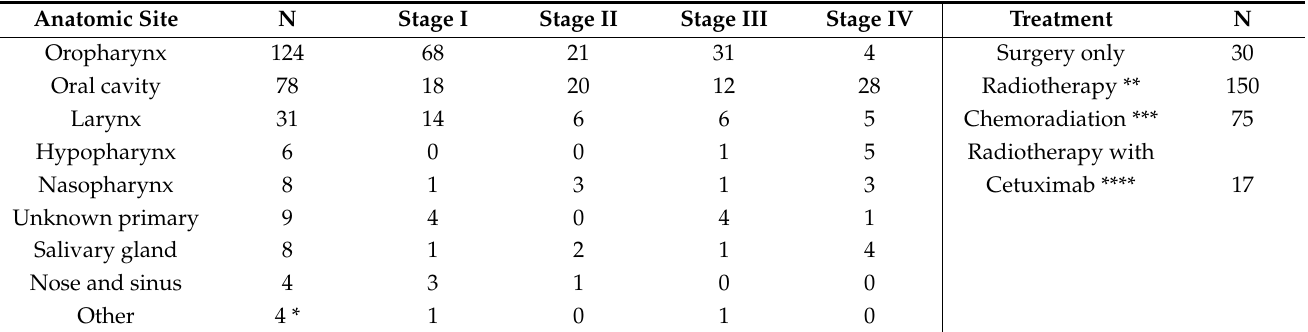
Table 1. Anatomic site and stage of the disease at pre-treatment and treatment of the